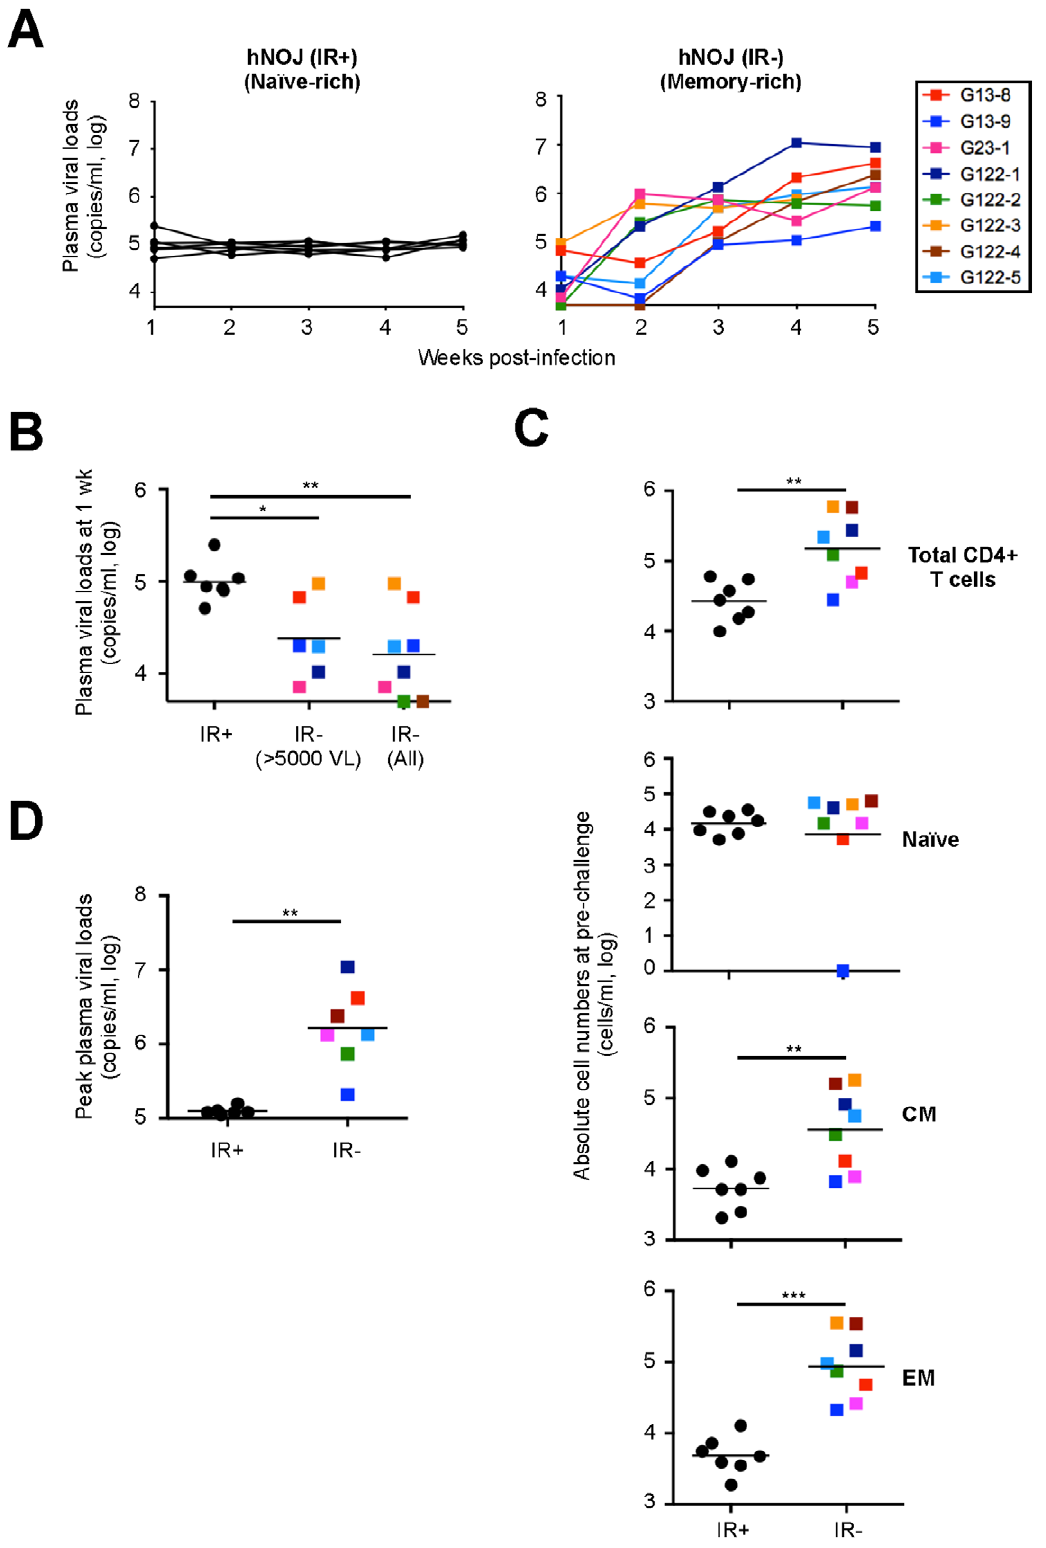
Figure 7. Invivo R5 HIV-1 infection in hNOJ mice. hNOJ mice were challenged intravenously with HIV-1 NL-AD8-D and divided into two groups: naı¨ve-rich hNOJ (IR + ) mice at 10 wk post-transplantation ( n =7) and memory-rich hNOJ (IR 2 ) mice at $ 12 wk post-transplantation ( n =8), based on the percentage of each individual CD4 + T cell subsets at pre-challenge. (A) Weekly analysis of the plasma viral load. Individual hNOJ (IR 2 ) mice are denoted by different colors in this and in the following figures. (B) The plasma viral load at 1 wk post-challenge. Data are plotted individually along with the mean (black lines). Significant differences ( * P , 0.05, ** P , 0.01) between hNOJ (IR + ) mice ( n =7) and hNOJ (IR 2 ) mice in which the plasma viral